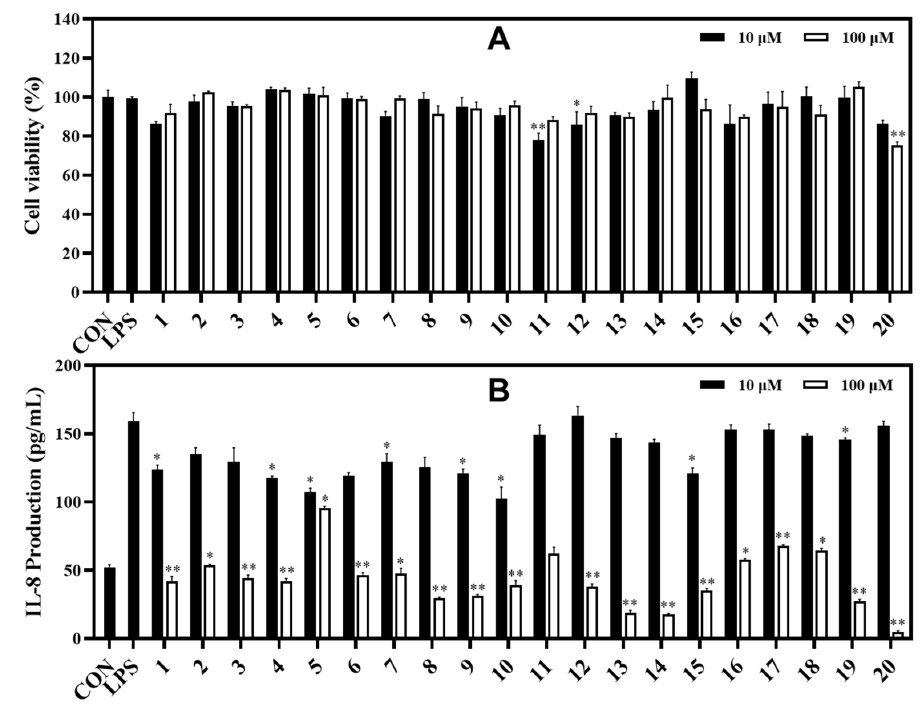
Figure 6. Cytotoxic effects ( A ) and IL-8 production inhibitory effects ( B ) of compounds in LPS-induced HT-29 cells. HT-29 cells were treated with compounds 1 − 20 (10 and 100 µM) for 2 h and stimulated with LPS (100 ng/mL) for 12 h. ( A ) The viability of cells was determined using an MTT assay. ( B ) The level of IL-8 in the culture media was measured with an ELISA kit. The values are expressed as mean ± standard deviation of three individual experiments. * p < 0.05, ** p < 0.01, compared to the LPS-treated group.